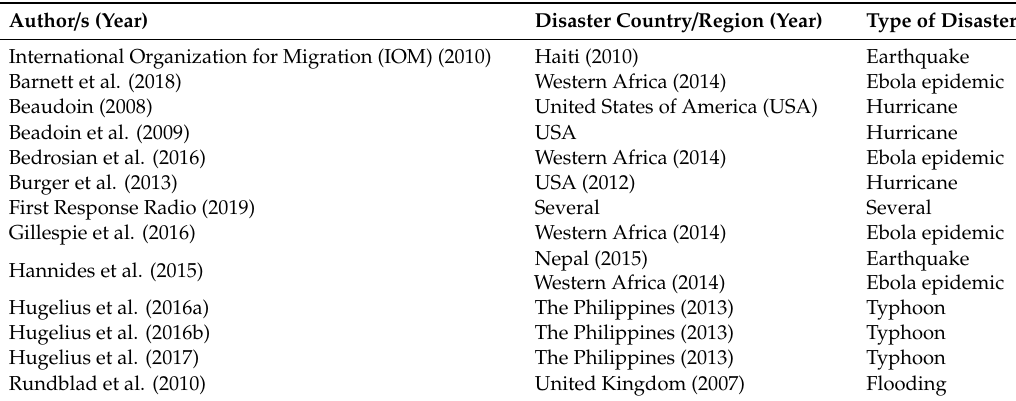
Table 2. Overview of the papers included in the